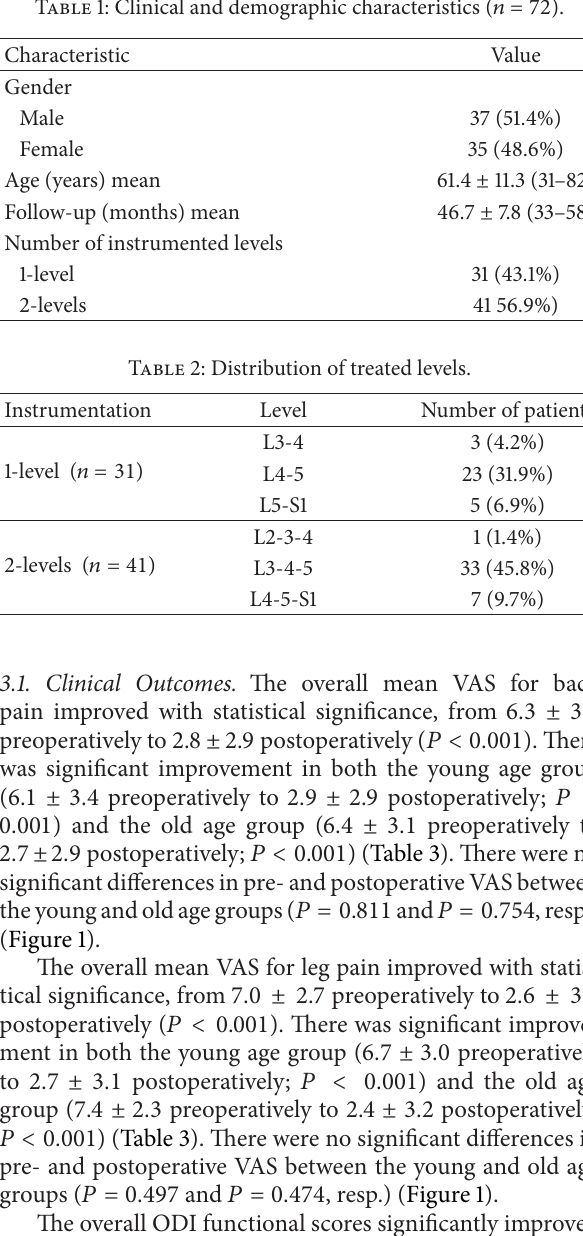
Table 3: Comparison between young age and old age.